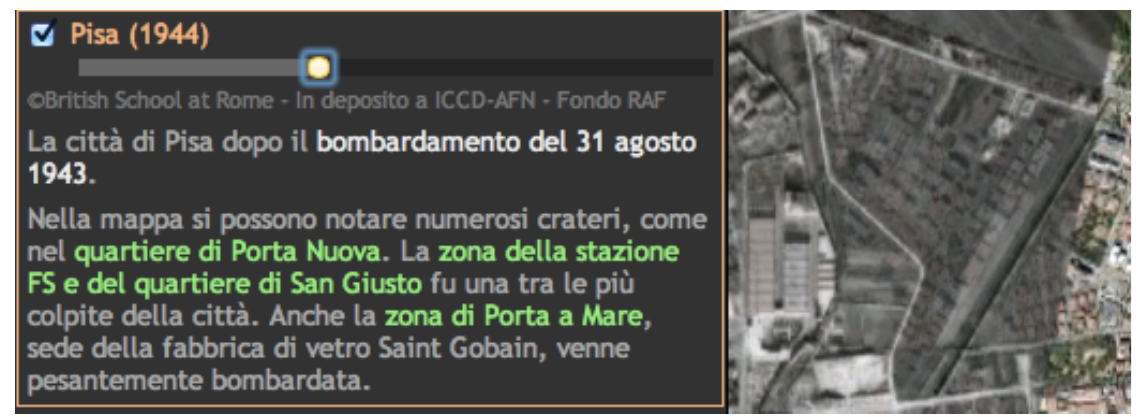
Figure 10. A closeup of the application showing how one map from 1944 was chosen and additional information about that map (in Italian) pops up. The slider can be used to blend the overlaid map with the Google Earth map. The green links can be clicked to navigate to the described portion of the map. ( c (cid:13) MiBAC-ICCD, Aerofototeca Nazionale, fondo RAF. c (cid:13) 2010 Google).